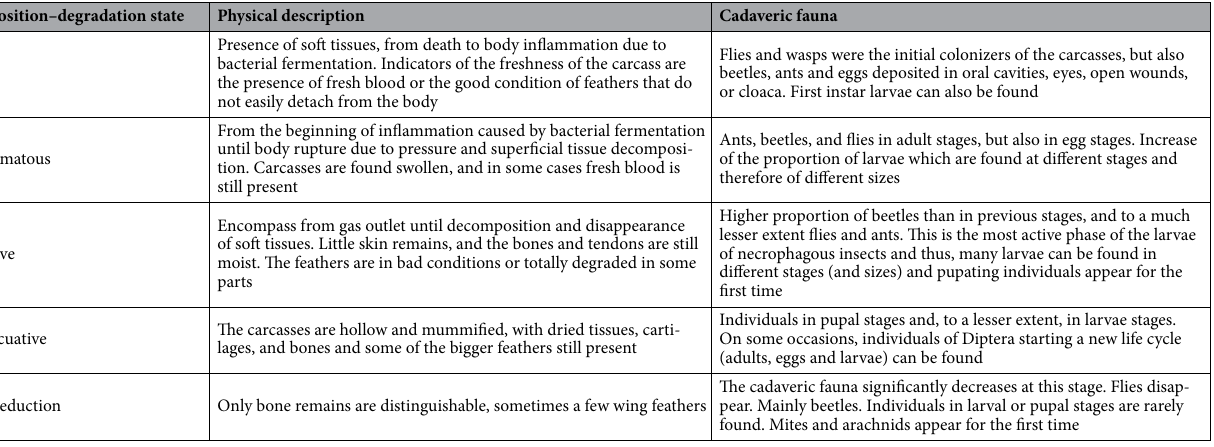
Table 1. Decomposition–degradation states. For each state the physical changes are indicated, as well as the associated cadaveric fauna. See Appendix A for further information and